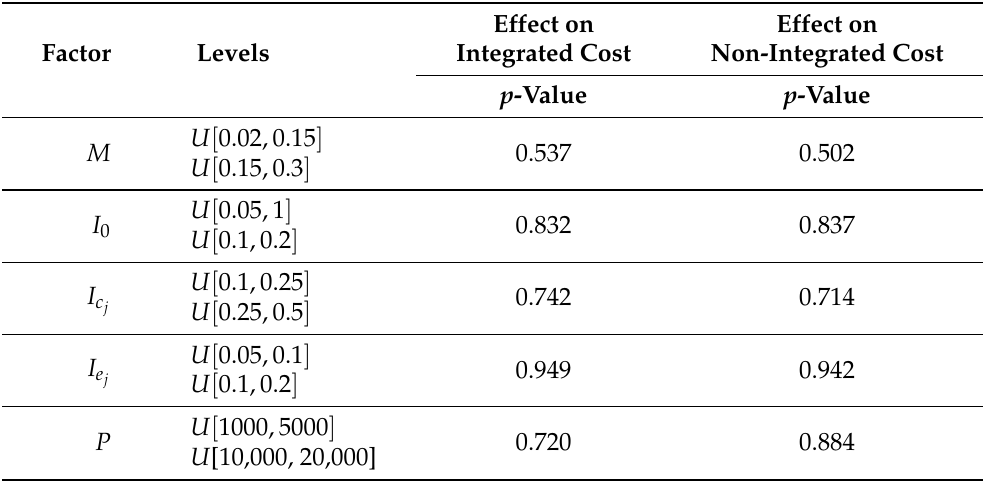
Table 10. The effects of the parameters M , I 0 , I c integrated